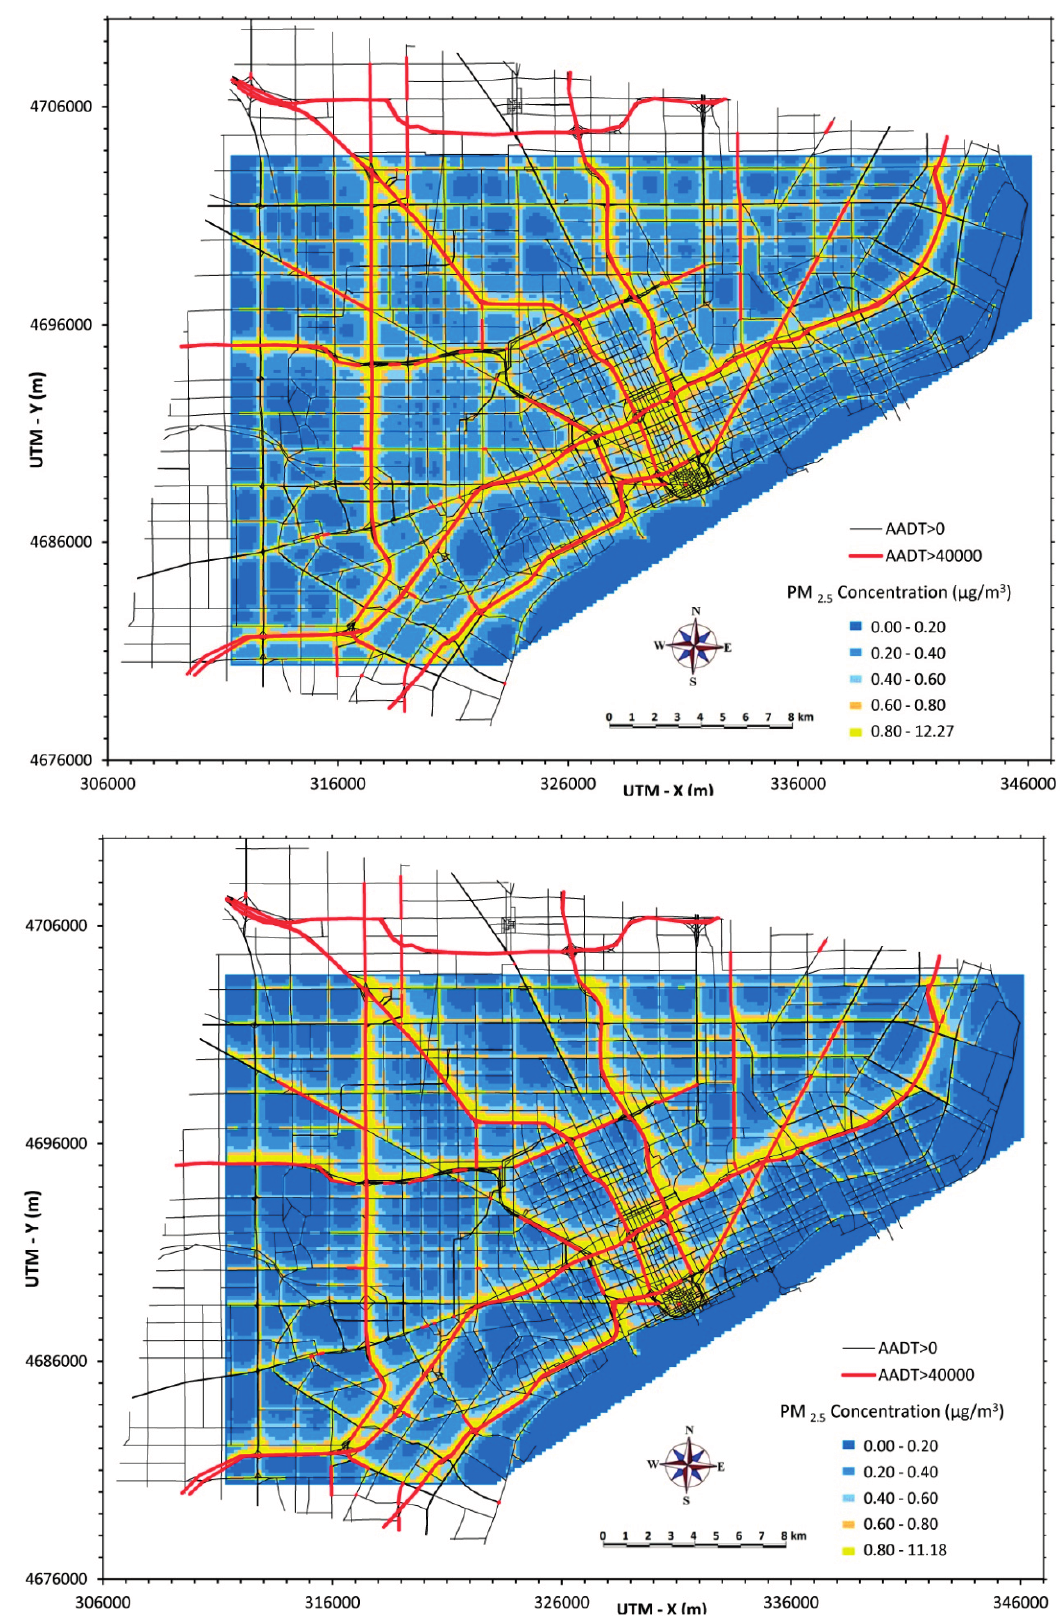
Figure 2. Daily (24-h) PM 2.5 concentrations from traffic emissions across Detroit (30 × 40 km) for 8 February 2010 (top) and 29 December 2010